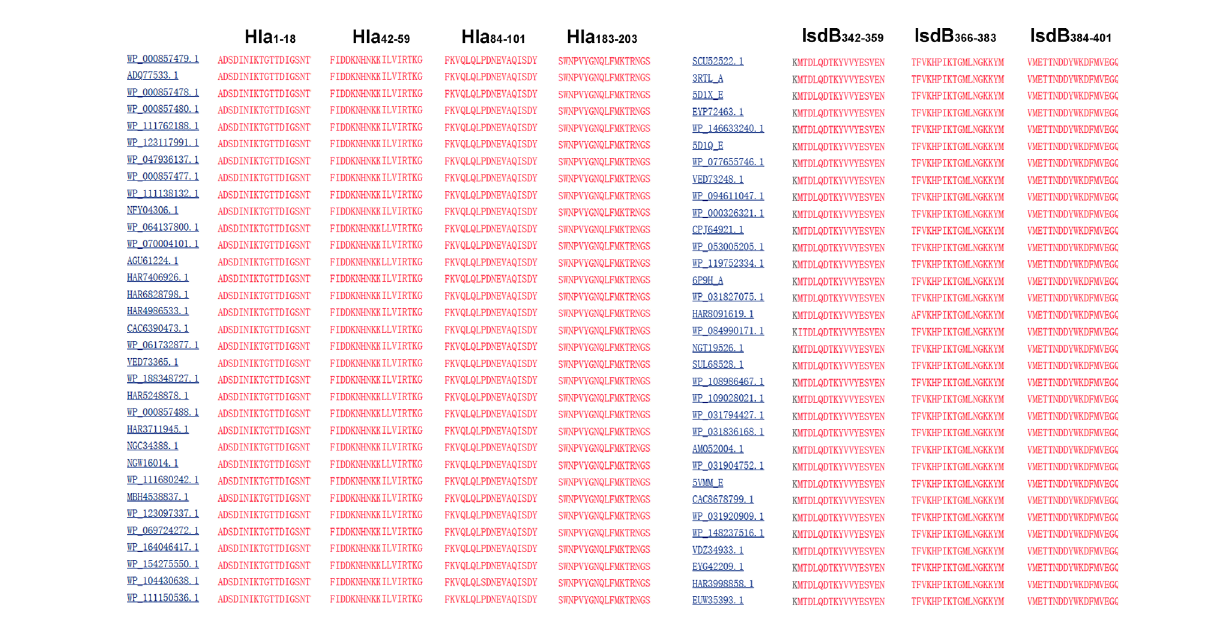
FIGURE 5 | Sequence alignment of the immunodominant epitopes on Hla and IsdB. The sequences of Hla and IsdB from 33 different S. aureus strains were retrieved from the GenBank database. These sequences were aligned using the NCBI Basic Local Alignment Search Tool (BLAST)